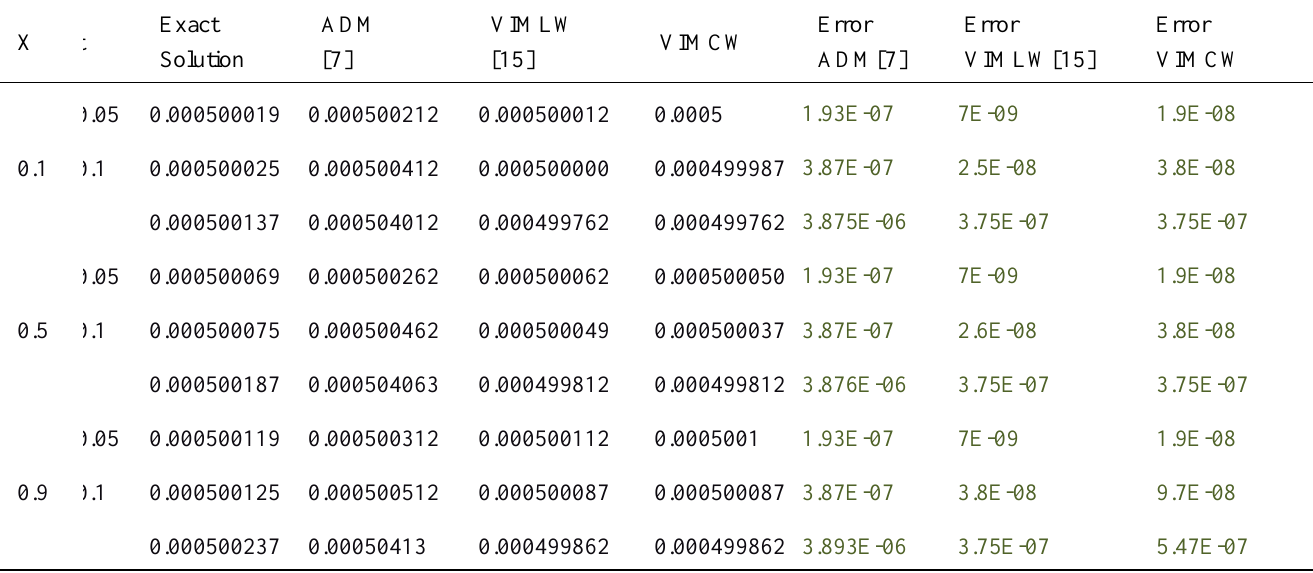
The Numerical Results for the ADM, VIMCW